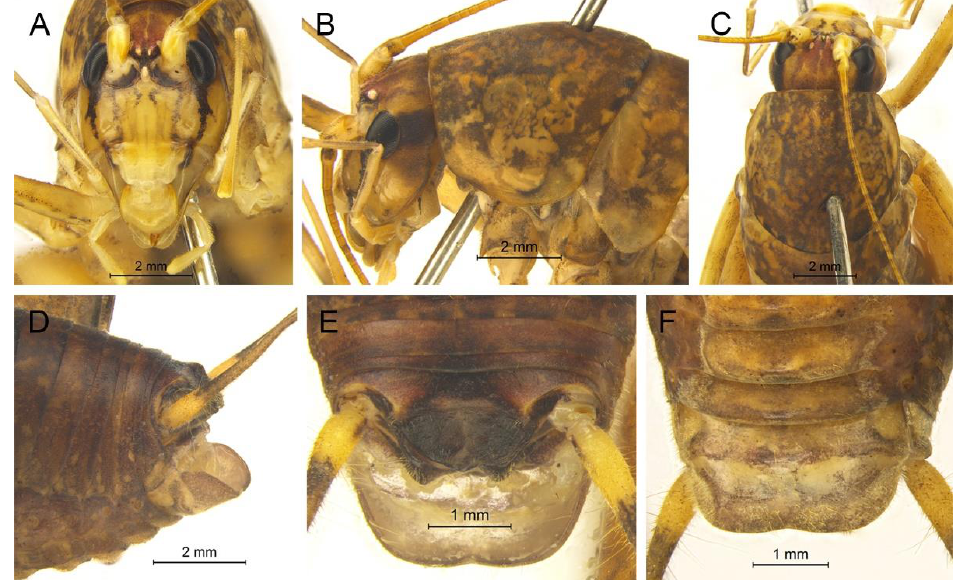
Figure 26. Homotachycines qinlingensis Zhu & Shi sp. nov., male: ( A – C ) head and pronotum: ( A ) frontal view, ( B ) lateral view, ( C ) dorsal view; ( D – F ) apex of abdomen: ( D ) lateral view, ( E ) dorsal view, ( F ) ventral view.